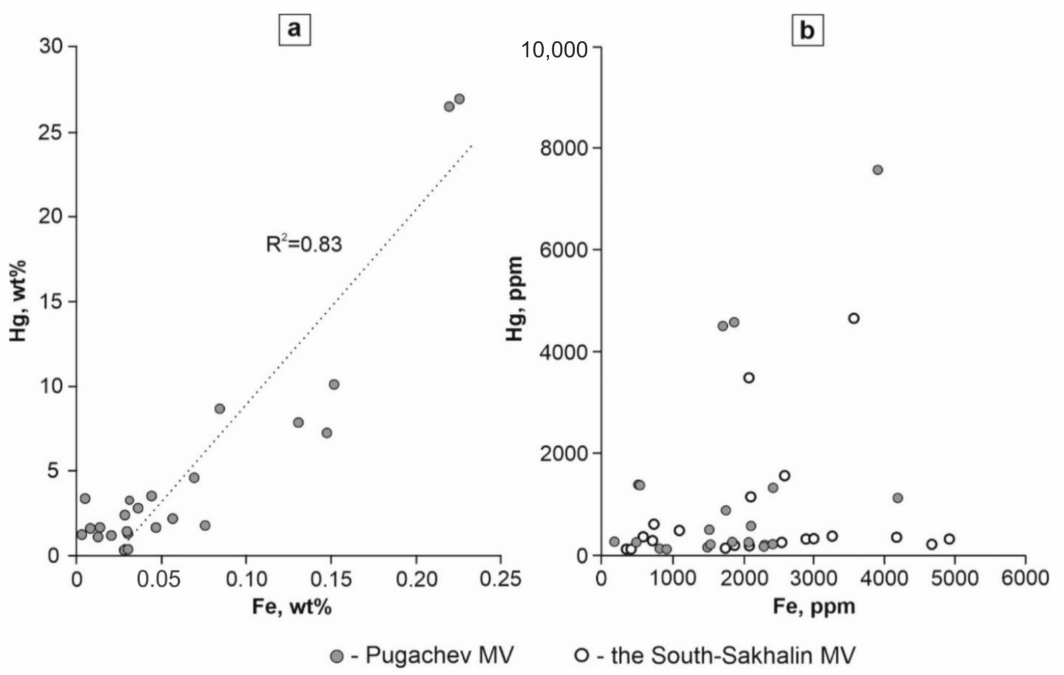
Figure 14. Hg/Fe ratios in shalerites from mud masses of Pugachev and South Sakhalin MVs. Hg and Fe contents: ( a ) in wt%, WDS-EDS data; ( b ) in ppm, LA-ICPMS data.